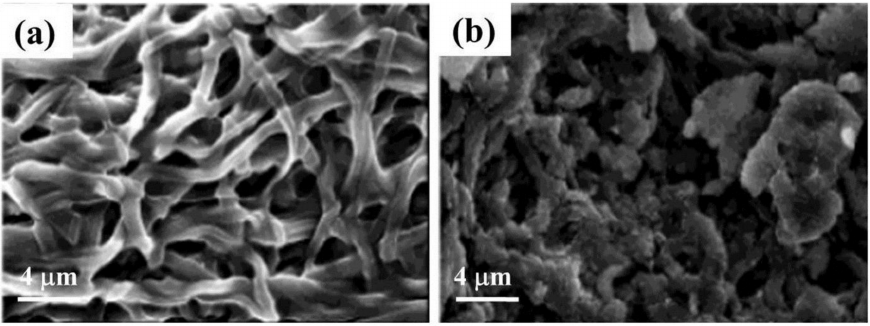
Figure 7. SEM images of oxidized cellulose acetate nanofibers ( a ) In HNO 3 /H 3 PO 4 -NaNO 2 solvent ( b ) in HNO 3 /H 2 SO 4 -NaNO 2 solvent shown [113]. Reproduced with permission from ref. [113]. Copyright American Chemical Society,